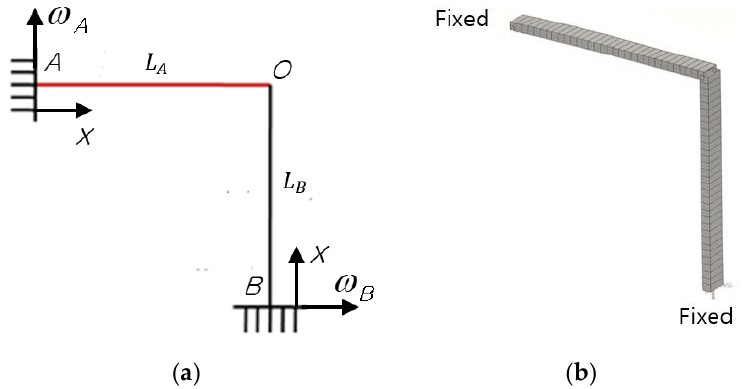
Figure 1. Structure model of two section type connected beam. ( a ) Simplify model; ( b ) finite element analysis (FEA)